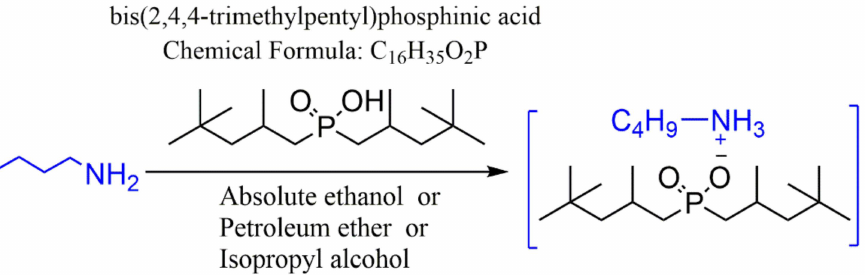
Figure 2. Synthetic reaction of [C 4 H 9 NH 3 ][Cyanex